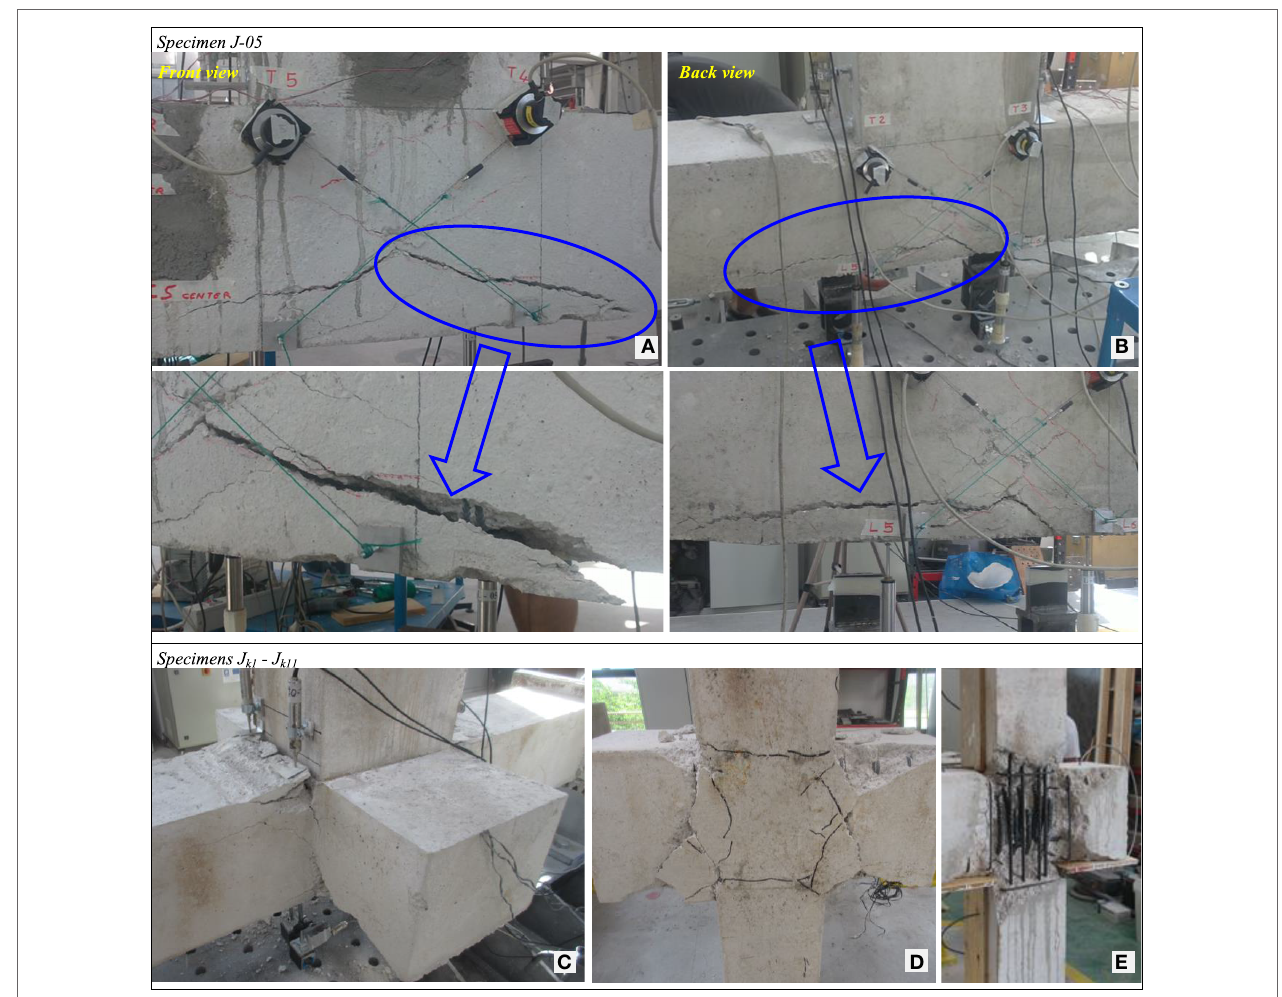
FIGURE 6 | Crack pattern and failure for control specimens: J-05 (A,B) ; J k1 and J k11 (C–E)